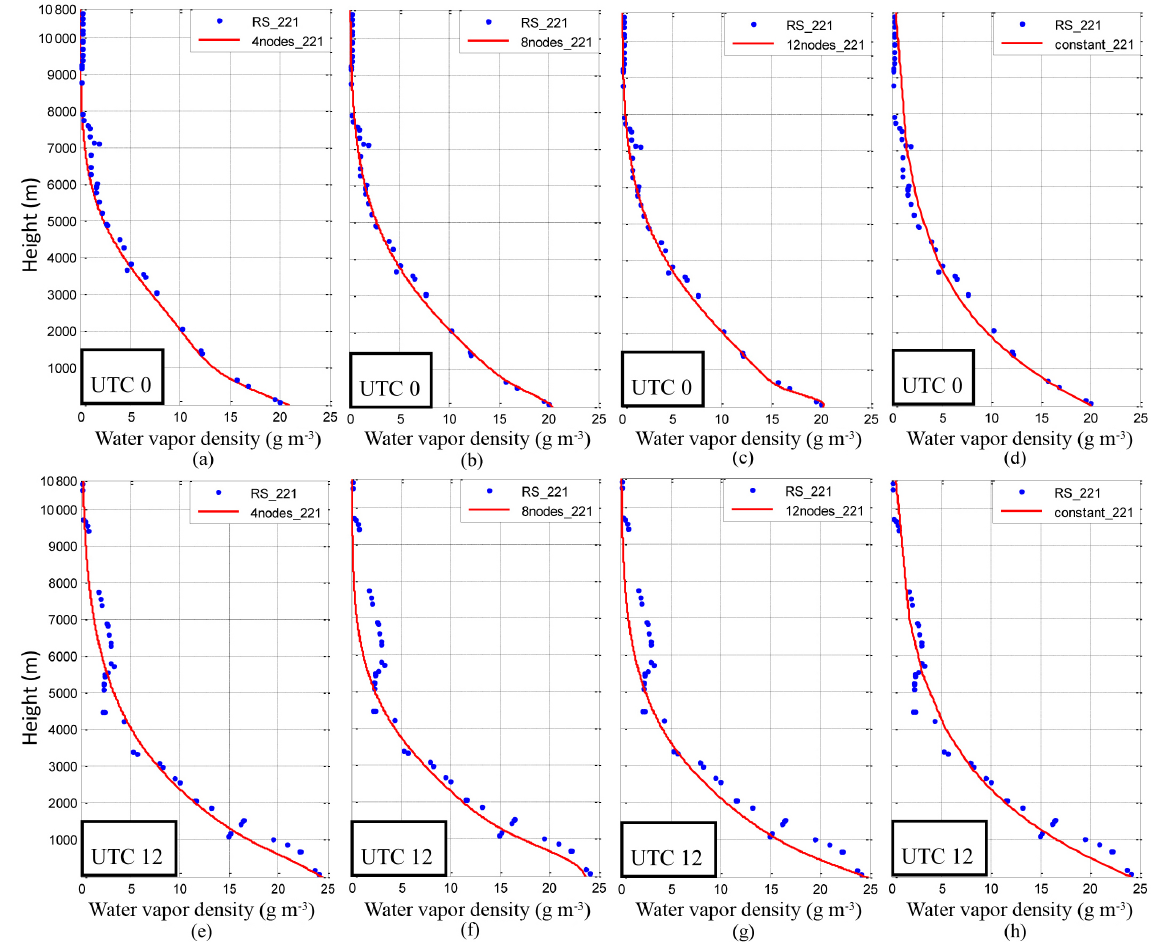
Figure 4. Comparison of HKKP’s radiosonde data (blue dot) with results of water vapor tomography schemes (red lines) at 00:00 and 12:00UTC, respectively (DOY 221 2015).